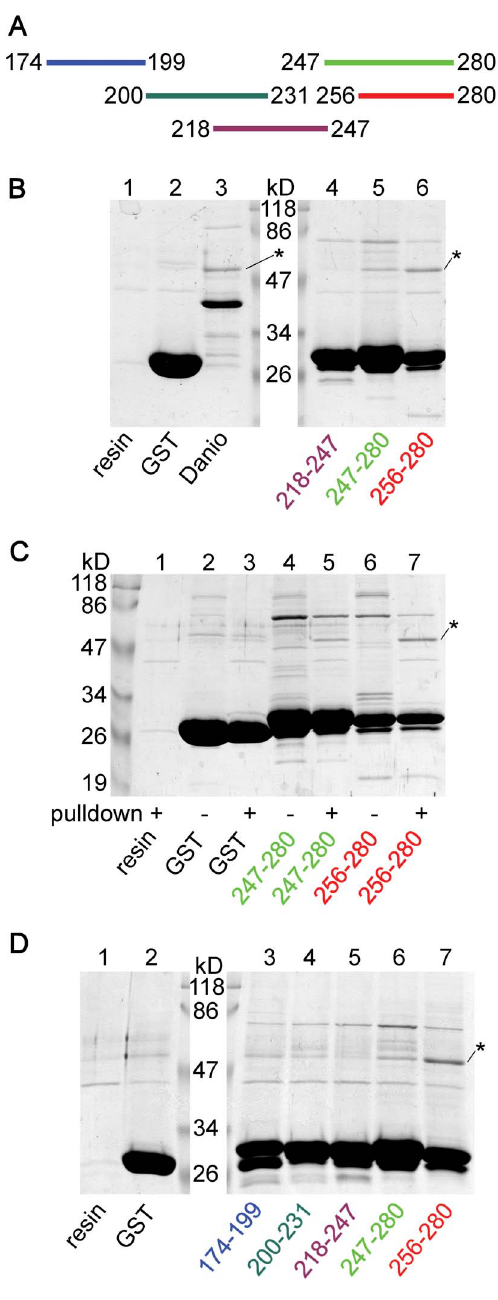
Figure 4. The C-terminal end of the cytoplasmic loop is a major determinant of tubulin-binding. A. GST fusion proteins were constructed from short (about 30 amino acid) fragments overlapping with the 174–280 region of human TRESK as indicated by the colored bars. B. Pull-down experiments (as in Fig. 3.B) were performed with the middle part (218–247, lane 4 ) and the C-terminal fragments (247–280 and 256–280, lane 5 and 6 ) of the cytoplasmic loop of TRESK. Tubulin interacted with the C-terminal fragments, but not with the middle part of the loop. The binding of tubulin to the C-terminal fragments was substantially stronger than that in the control reactions (compare lane 5 and 6 to lane 1 and 2 ). In lane 3 , tubulin was pulled down with a GST fusion construct containing the cytoplasmic loop (amino acids 174–284) of Danio rerio (zebrafish) TRESK. C. A similar control SDS-PAGE as in Fig. 3. C was performed with the C-terminal fragments (247–280 and 256–280, as indicated below the gel) to verify that the band corresponding to tubulin indeed derived from the cytosol. Note the presence of tubulin in the result of pull-down assays ( lane 5 and 7 )